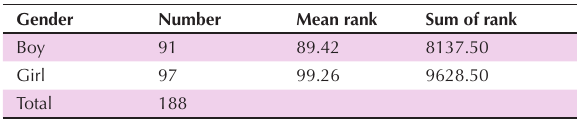
Table 1. Comparison of the duration of hospitalization based on sex (Mann- Whitney